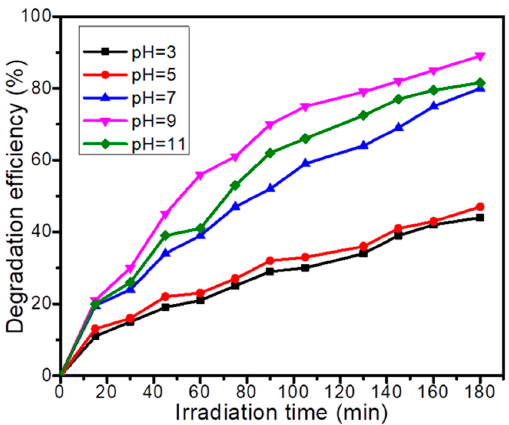
Figure 4. Effect of pH on photocatalytic degradation of amoxicillin (C 0 = 15 mg/L, catalyst dose = 1